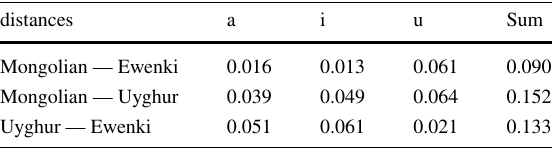
normalized values of the three